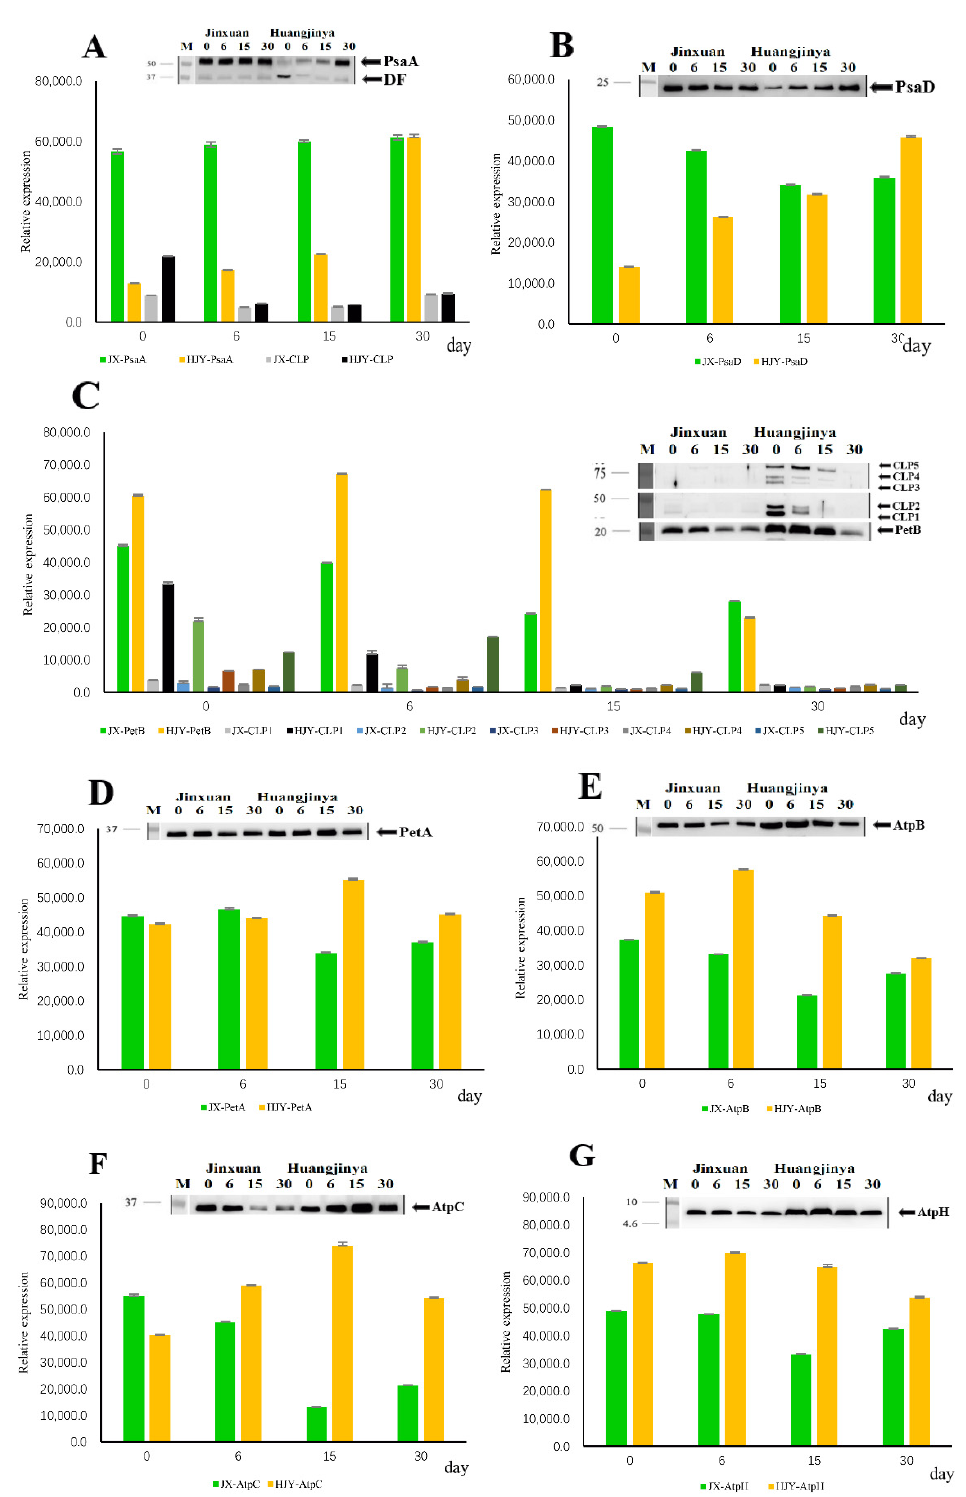
Figure 3. ( A – G ) Immunoblotting of partial subunits of electronic transport complexes. Thylakoids were extracted from the 4th leaf beneath apex bud on tea shoots, and 1 µ g of chlorophyll was used each lane. The blots were probed with the following specific antibodies: anti-PsaA, anti-PsaD, anti- PetB, anti-PetA, anti-AtpB, anti-AtpC, and anti-AtpH. CLP, crosslinking product; DF, degradation fragment. The data 0, 6, 15, and 30 refer to the days of shading treatment. The bars are expressed as mean ± standard deviation ( n = 3).